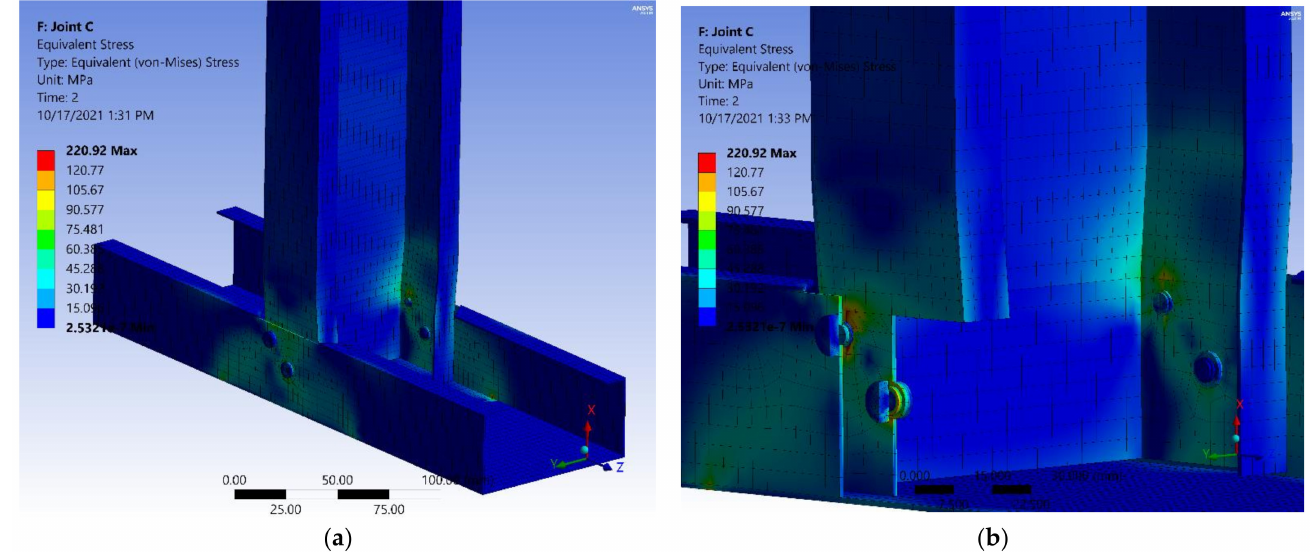
Figure 34. Joint C Equivalent stress: ( a ) overall; ( b ) details of screws with hidden